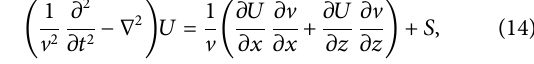
FIGURE 7 | Single-trace display of imaging results after 60 iterations.